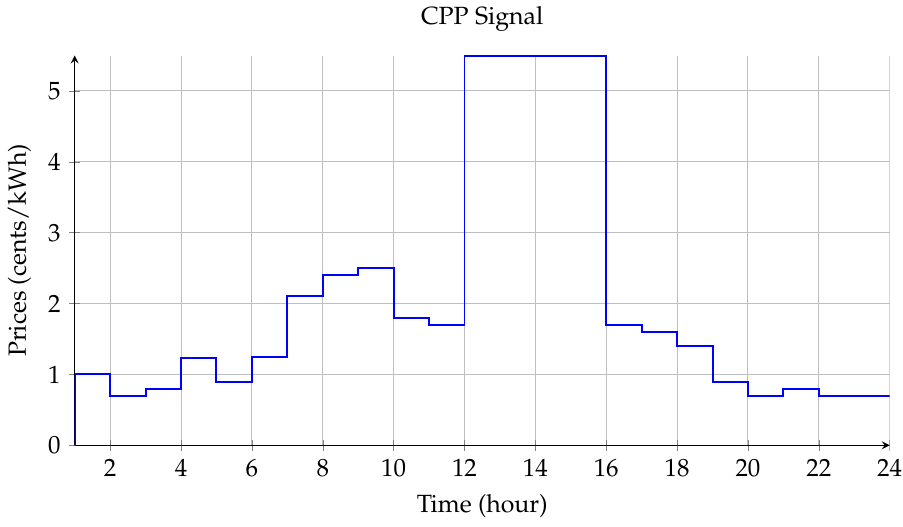
Figure 9. CPP tariff for each hour during a